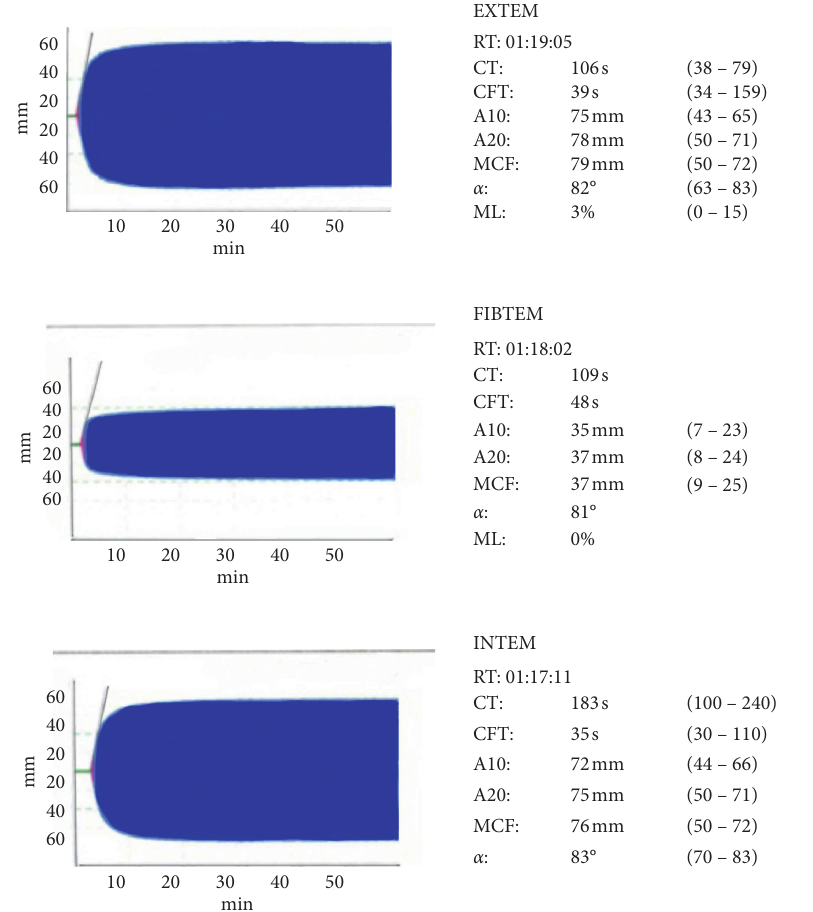
Figure 2: Rotational thromboelastometry (ROTEM) showing a procoagulant state despite the low numeric platelet